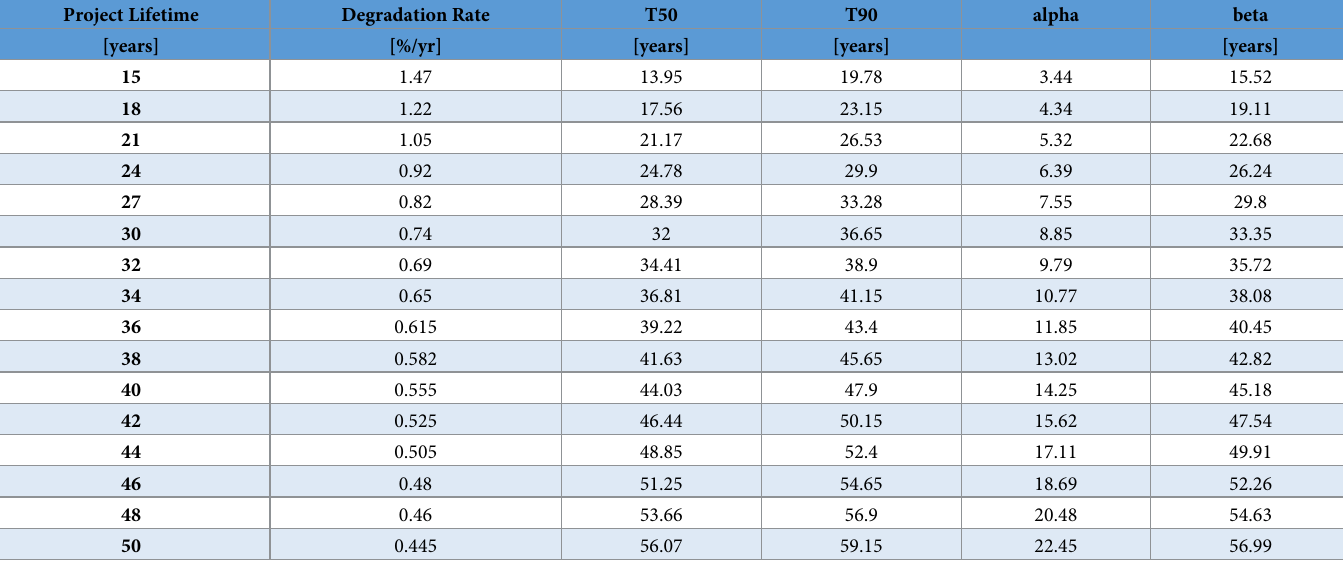
Table 2. Module lifetime parameters. Module lifetime parameters used to model modules of different lifetimes. Project